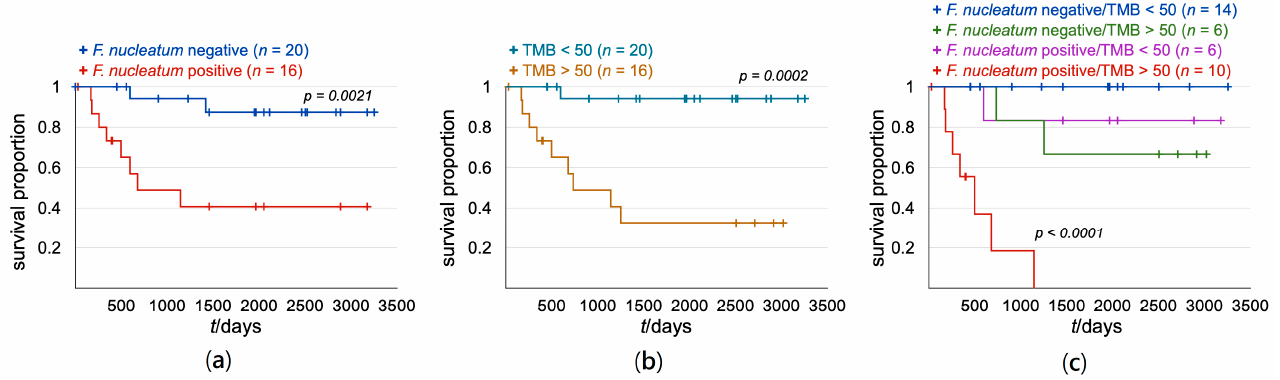
Figure 5. The Kaplan–Meier analysis of the patients. ( a ) The analysis carried out by stratifying the patients into the F. nucleatum -negative and -positive groups. ( b ) The analysis carried out by stratifying the patients into the TMB < 50 and TMB > 50 groups. ( c ) The patients were striated into four groups for survival analysis according to the status of F. nucleatum and TMB. The statistical significance was obtained between the patient without F. nucleatum infection and TMB < 50 and those with F. nucleatum infection and TMB > 50.